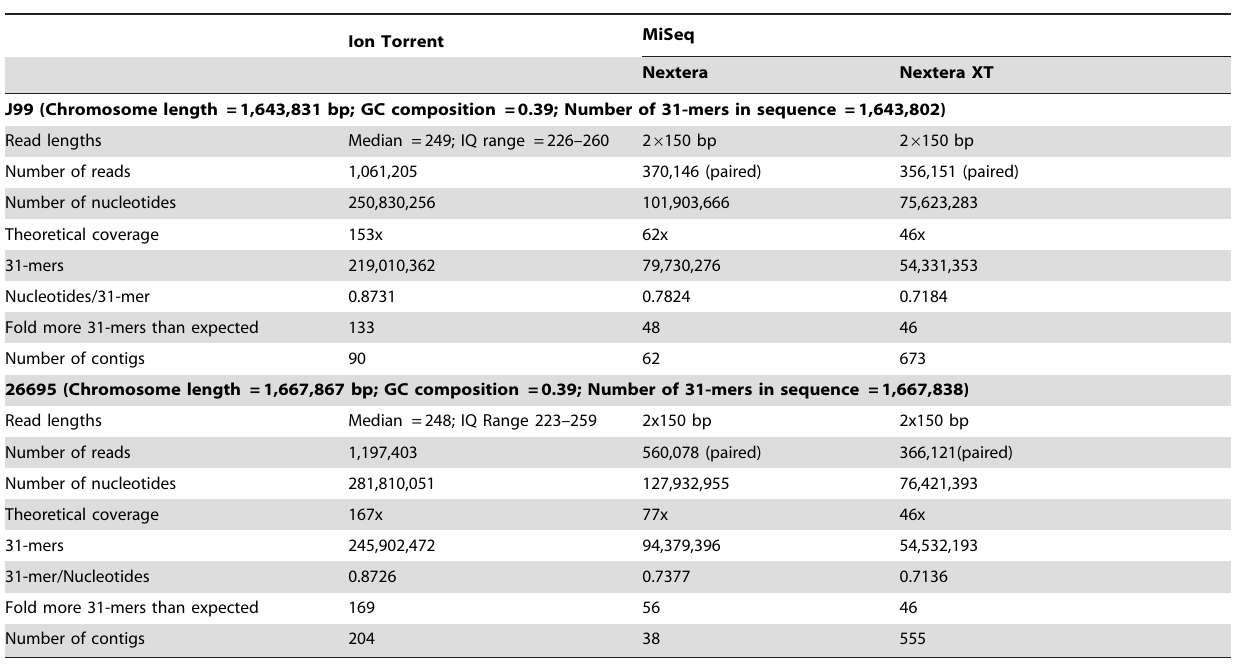
Table 1. Analysis of raw sequencing